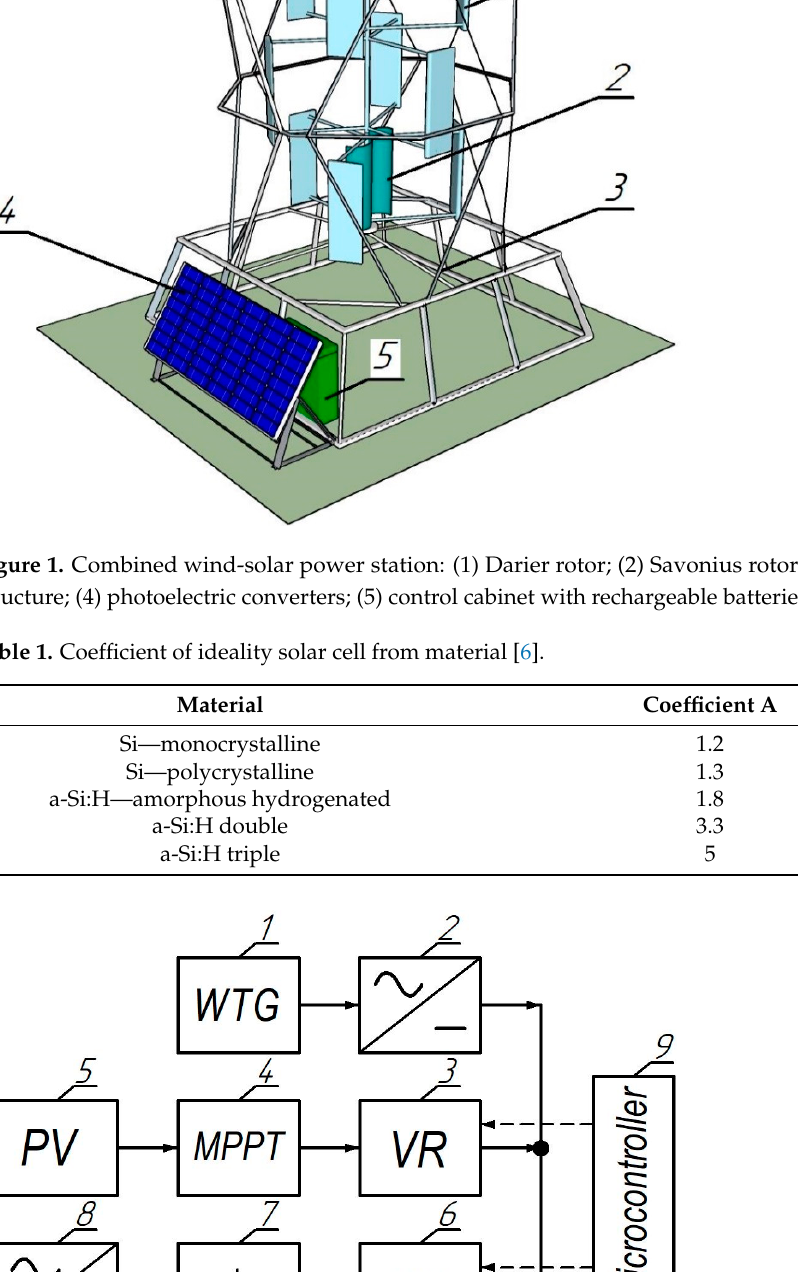
Table 1. Coefficient of ideality solar cell from material [6].